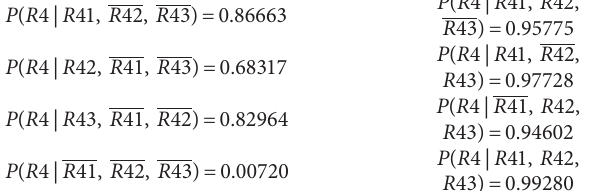
Conditional probability table for the node “capital resource